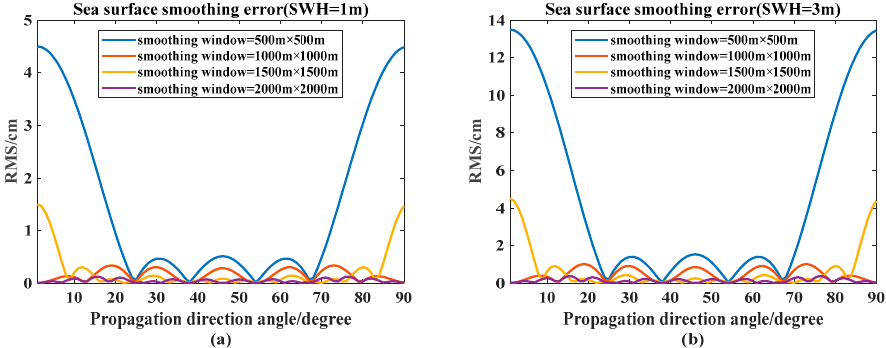
Figure 7. Effect of smoothing window on monochromatic waves of different wavelengths (in cm). The SWH is selected as 1 m ( a ) and 3 m ( b ), the wave direction is 0° and the pixel size is 5 m × 5 m. The smoothing window is a square window. ( c ) and ( d ) are the magnification of the smooth window results from 500 m to 2000 m in (a) and (b), respectively.